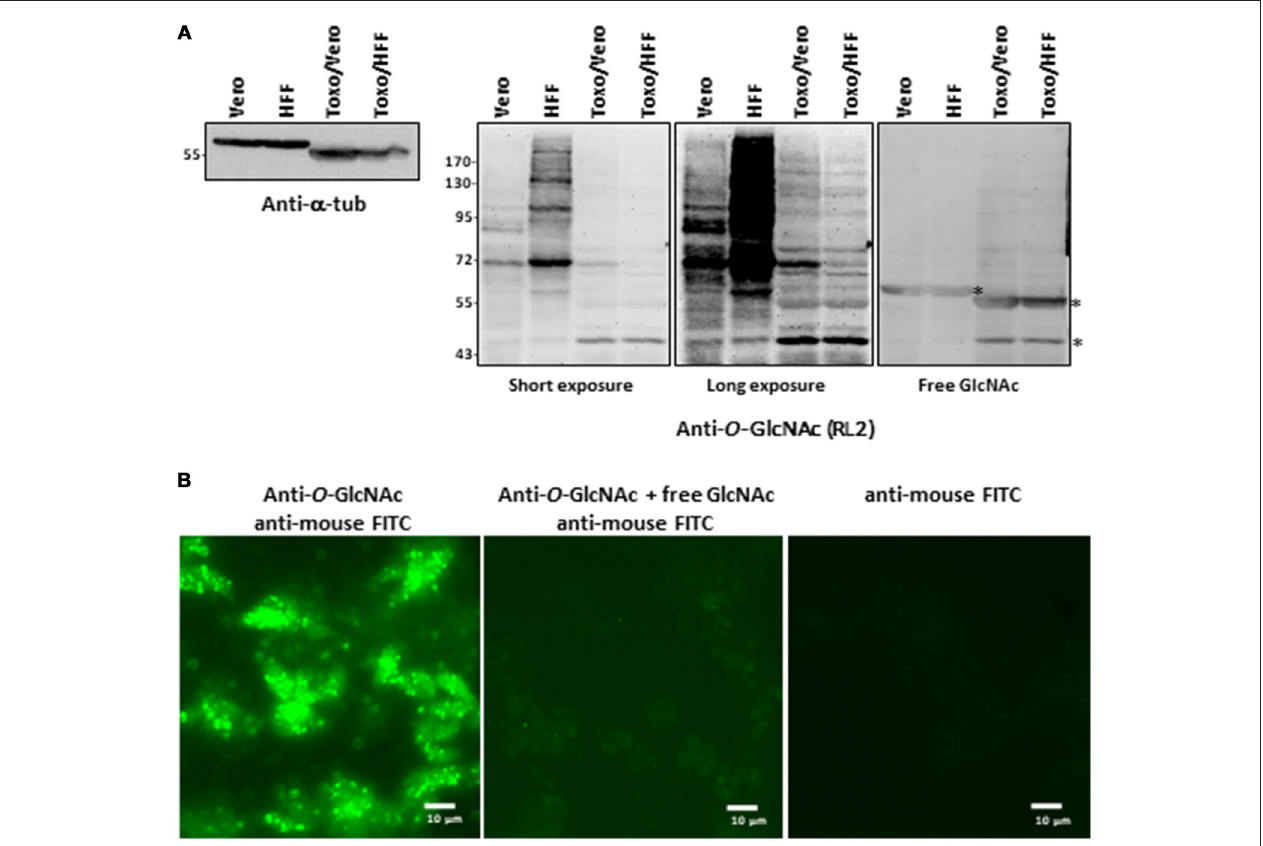
FIGURE 1 | (A) Parasites were produced either in Vero cells or HFF. After homogenization, proteins were resolved by SDS-PAGE and electroblotted onto nitrocellulose and probed with anti-alpha-tubulin antibody or with RL2 anti- O -GlcNAc antibody alone or in conjunction with free GlcNAc to analyse their purity and their O -GlcNAcylation content respectively. (B) Parasites were stained with anti- O -GlcNAc antibody as primary antibody and FITC-labeled anti-mouse as secondary antibody and imaged by fluorescent microscopy. Controls were done by co-incubation of anti- O -GlcNAc antibody with free GlcNAc and by staining with secondary antibodies alone.*, unspecific bands. HFF, human foreskin fibroblast; T.g., Toxoplasma gondii ; FITC, Fluorescein